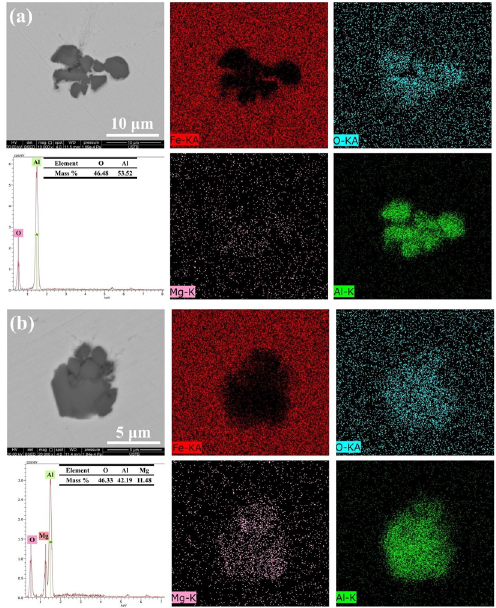
Figure 3. Typical inclusion morphology and makeup of Sample A: ( a ) Al 2 O 3 inclusion; ( b ) Al 2 O 3 · MgO inclusion.